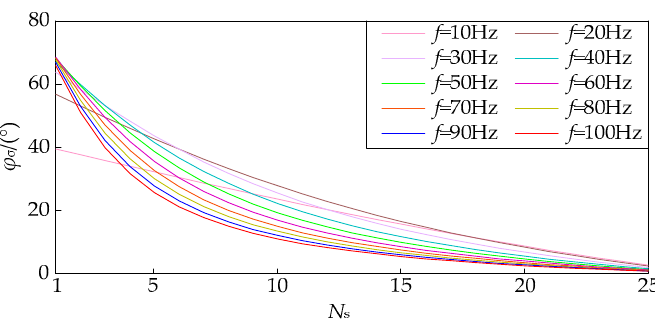
N . s N . s N . s N . s